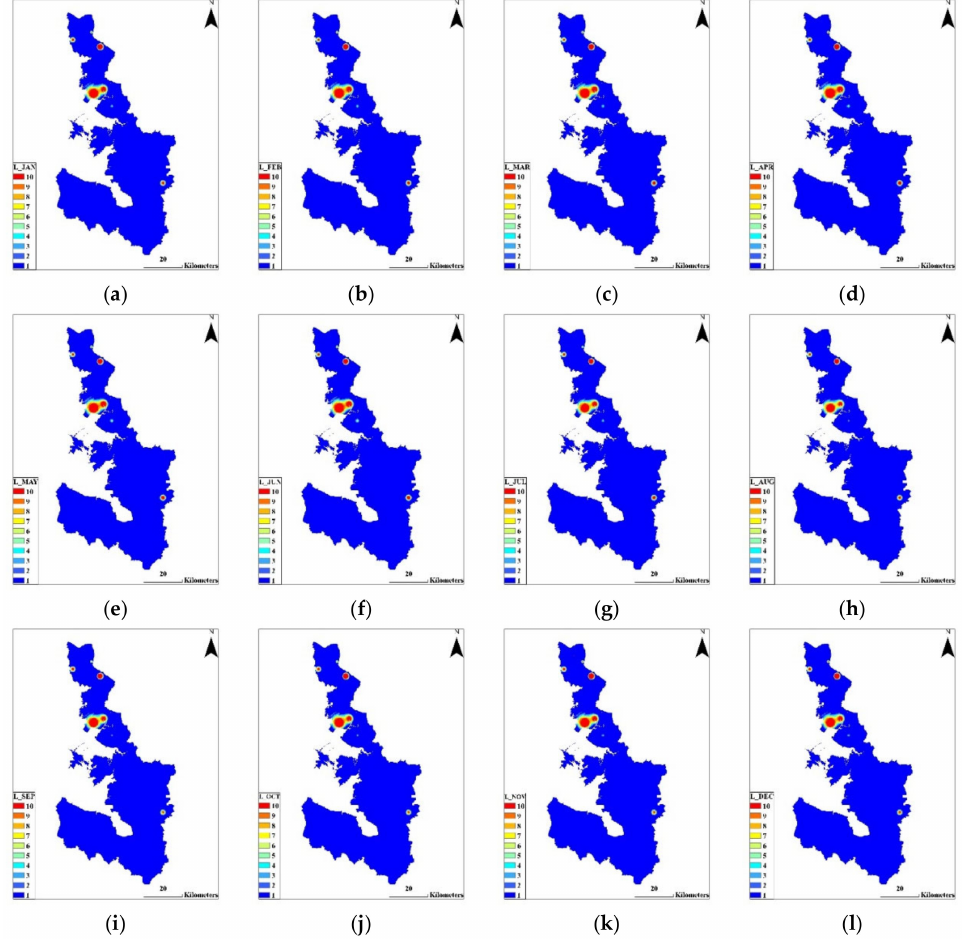
Figure 6. Thematic maps of the dynamic parameter’s rating for 10-year-averaged monthly height of groundwater level above sea level (L); ( a ) JAN; ( b ) FEB; ( c ) MAR; ( d ) APR; ( e ) MAY; ( f ) JUN; ( g ) JUL; ( h ) AUG; ( i ) SEP; ( j ) OCT; ( k ) NOV; ( l )